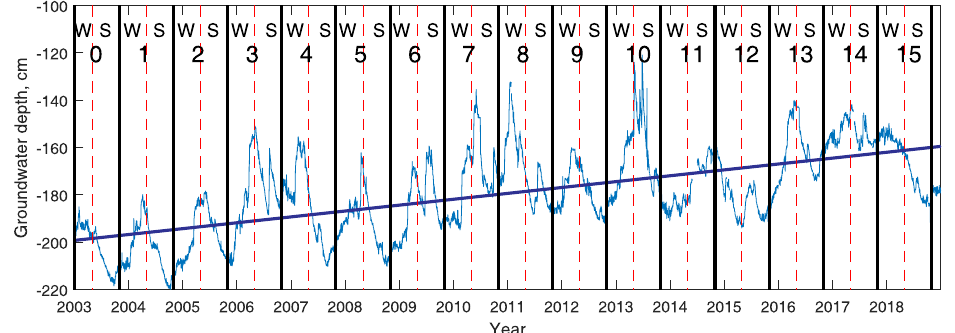
Figure 6. Time series of the groundwater level. The hydrological year is marked by the black line. Additionally, the summer/winter seasons are indicated with red broken